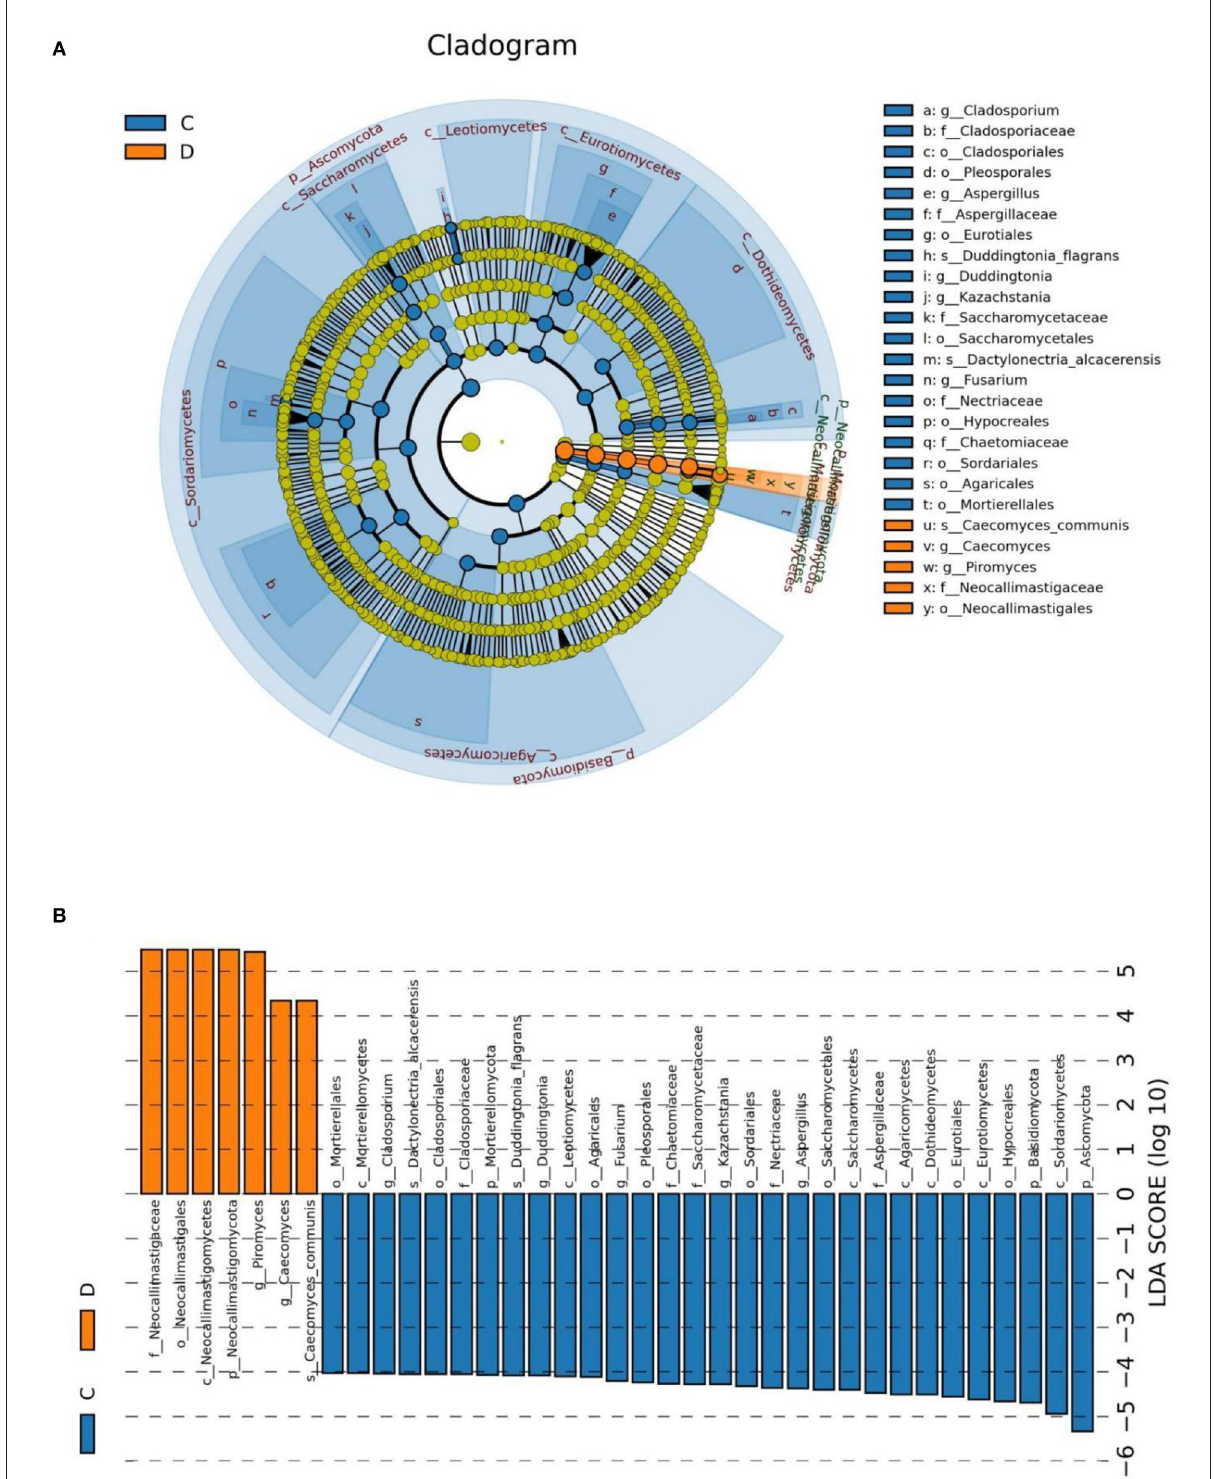
FIGURE5 The identification of differential fungi associated with diarrhea. (A) Cladogram indicating the phylogenetic distribution of microbiota correlated with the healthy or diarrheic horses. (B) The differences in abundance between the healthy and diarrheic horses. C and D represent healthy and diarrheic groups,